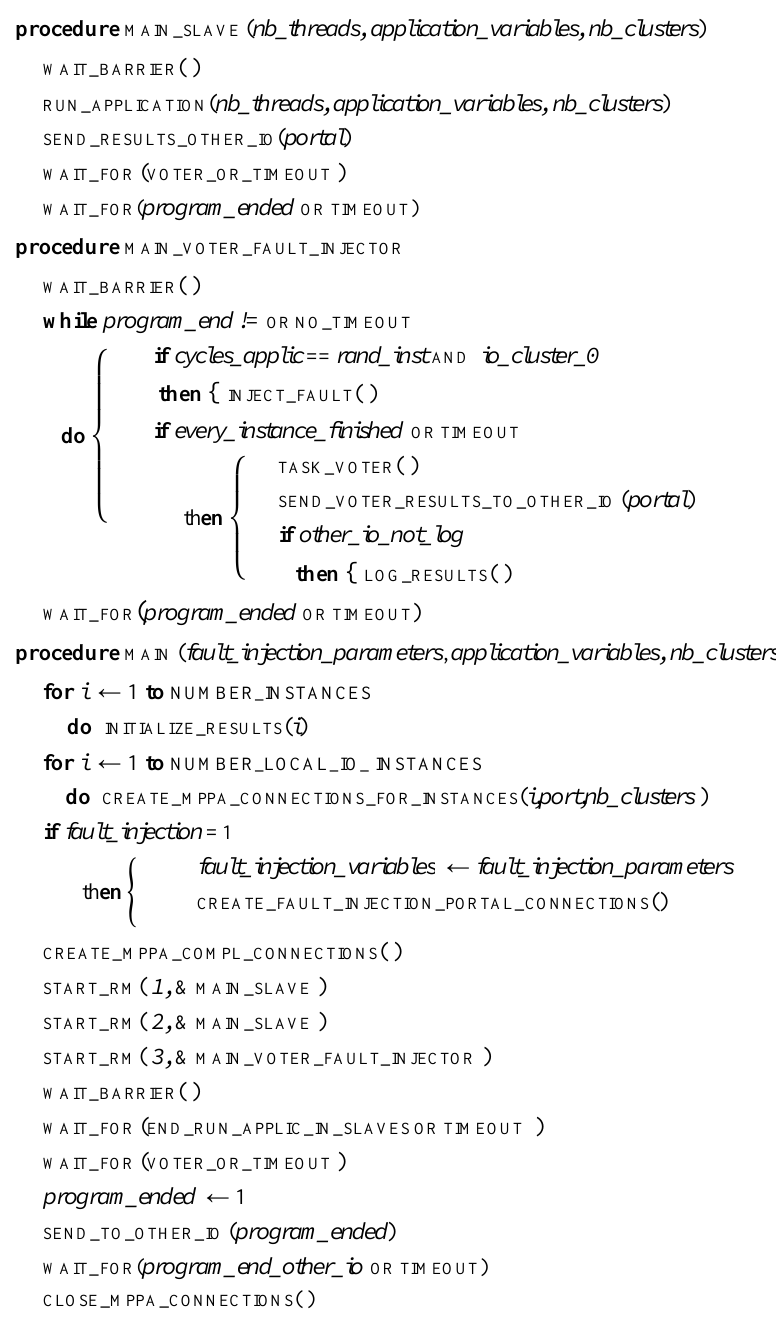
Figure A1. Pseudo-code for the implementation of the NMR-MPar applied to the